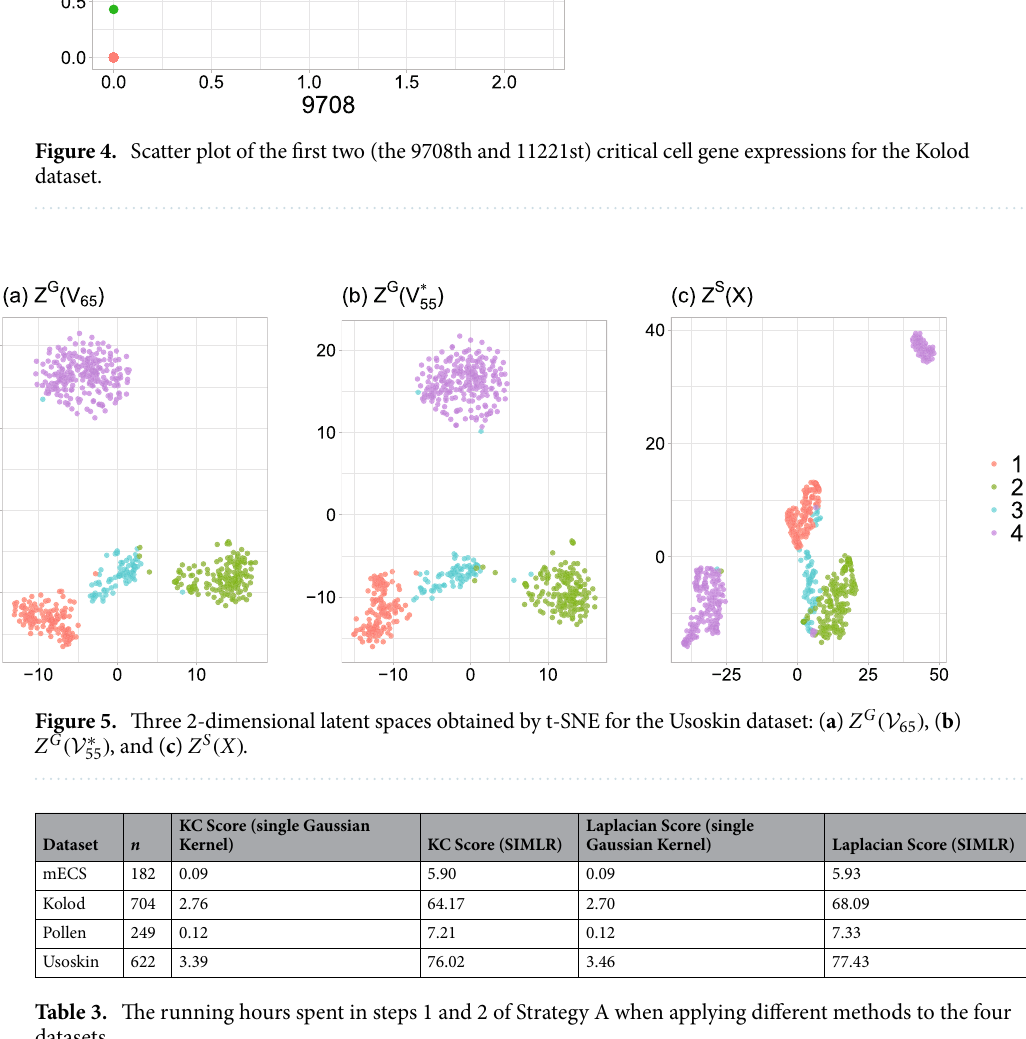
Table 3. The running hours spent in steps 1 and 2 of Strategy A when applying different methods to the four